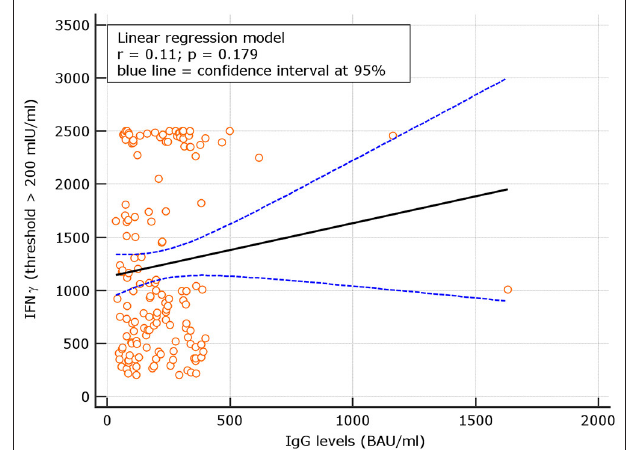
FIGURE 6 | Day 180, linear regression between IgG levels and IFN- γ concentration among naive group using the IFN- γ threshold of 100 mIU/ml.